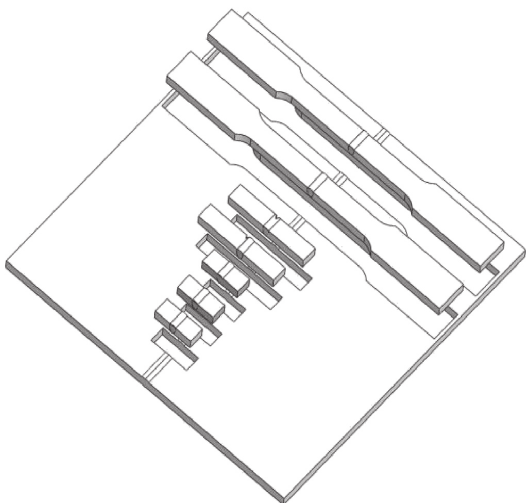
Figure 2: Different test specimens on welded TIG and ATIG plate.